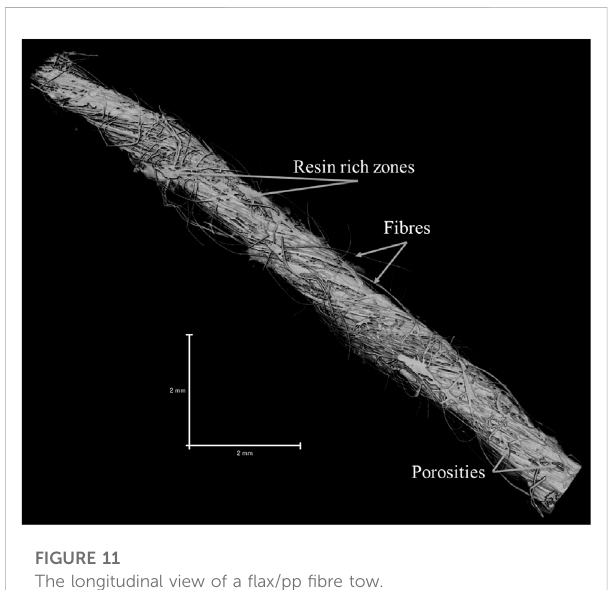
FIGURE 11 The longitudinal view of a fl ax/pp fi bre